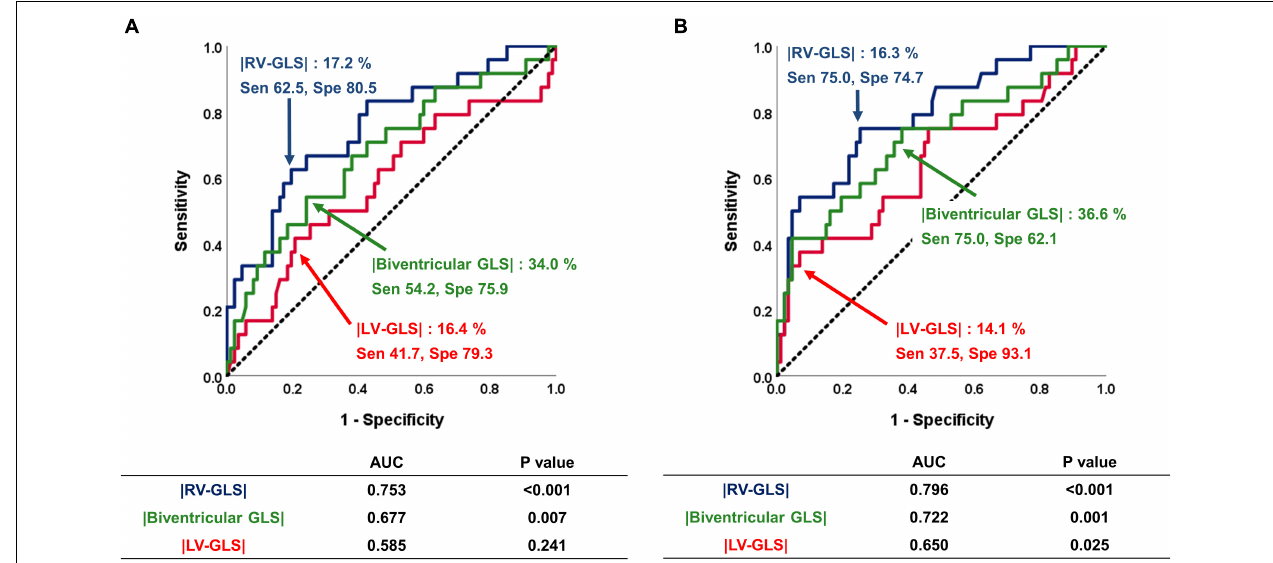
FIGURE 3 | Predictive value of |LV-GLS|, |RV-GLS|, and biventricular |GLS| for the occurrence of negative clinical outcomes. (A) On the pre-op echocardiogram, |RV-GLS| and biventricular |GLS| had significant predictive value for clinical outcomes. (B) On the post-op echocardiogram, |RV-GLS| showed better predictive value for clinical outcomes than biventricular |GLS| and |LV-GLS|. LV, left ventricle; |GLS|, absolute value of global longitudinal strain; RV, right ventricle.